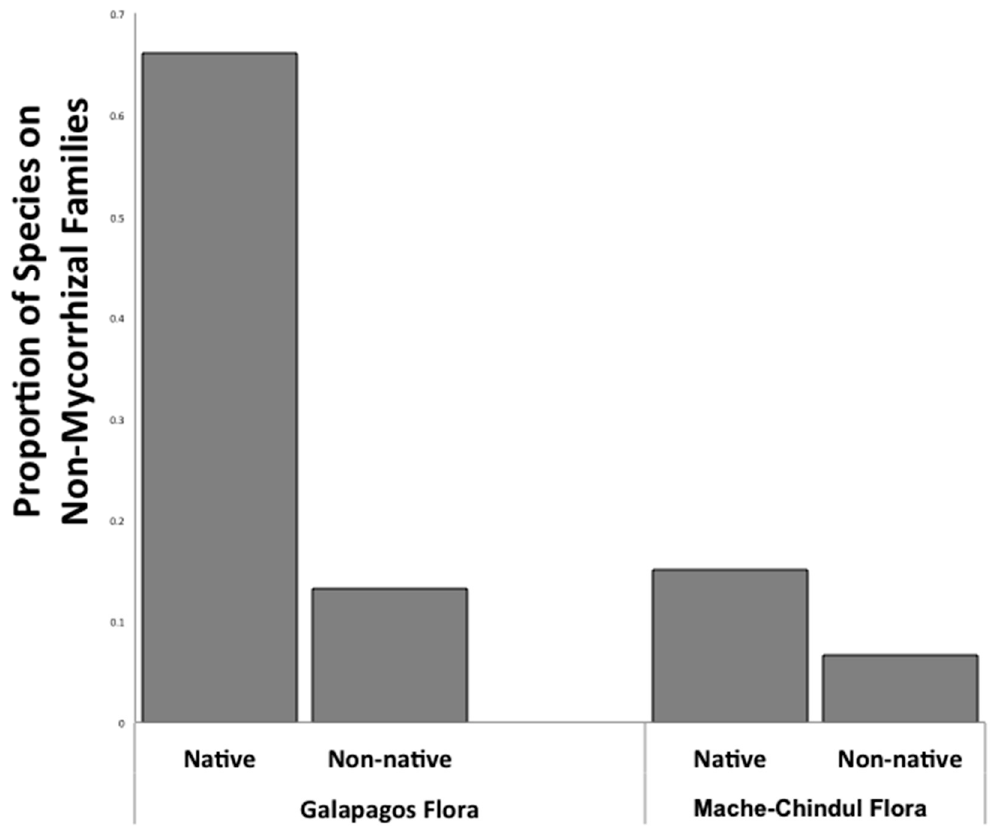
Figure 1. Pattern of nonmycorrhizal plant species in native and non-native flora of the highlands of Santa Cruz Island, Galapagos Archipelago, and flora of Mache-Chindul, mainland Ecuador. Santa Cruz Island, Galapagos Archipelago, and flora of Mache-Chindul, mainland